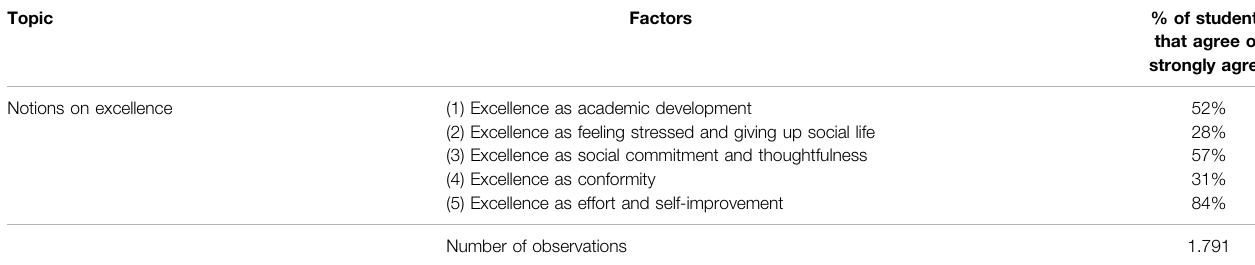
TABLE 4 | Estimated indices, interpretation and percentage of students that agree or strongly agree on the notion of